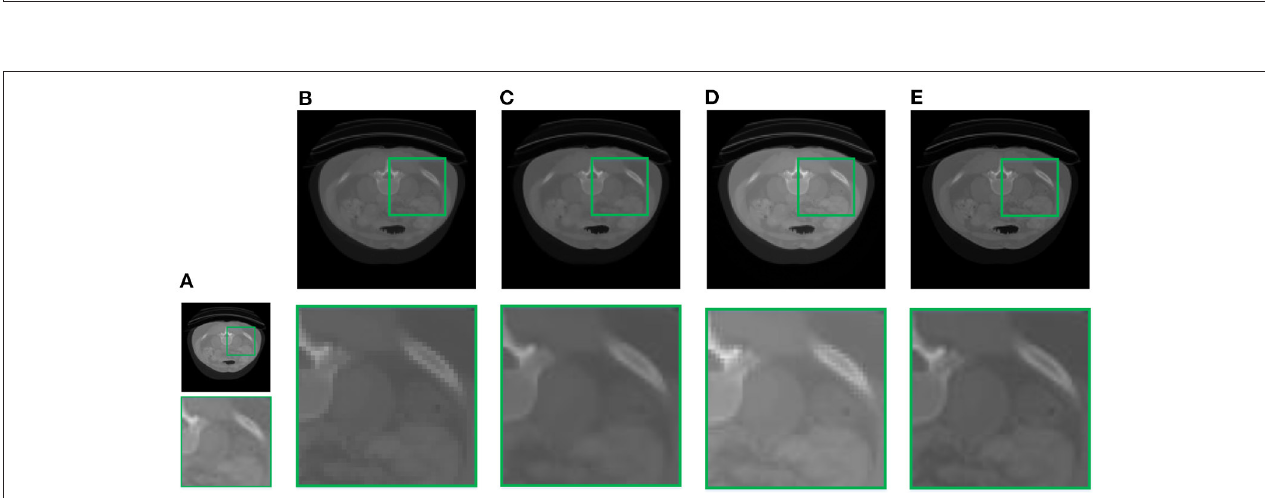
FIGURE 4 | Reconstruction results and their corresponding details of synthetic brain MRI data from Brainweb database: (A) Low-resolution (LR) band with downsampling factor 2, (B) nearest neighbor (NN), (C) low-rank and total variation regularizations (LRTV), (D) TF-SISR, (E) nonconvex nonlocal Tucker decomposition with weighted 3D total variation (NNTDTV).